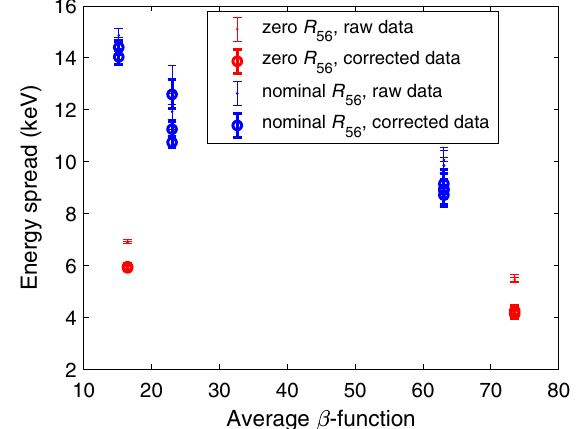
FIG. 5. Energy spread measurements as a function of the lattice optics for two different R 56